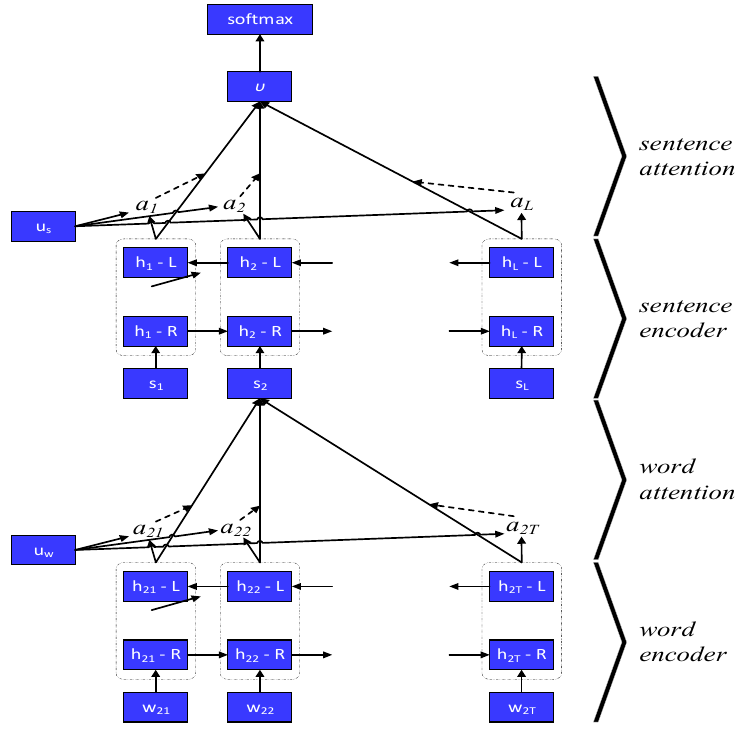
Figure 3. The structure and functionality of a self-attention mechanism.